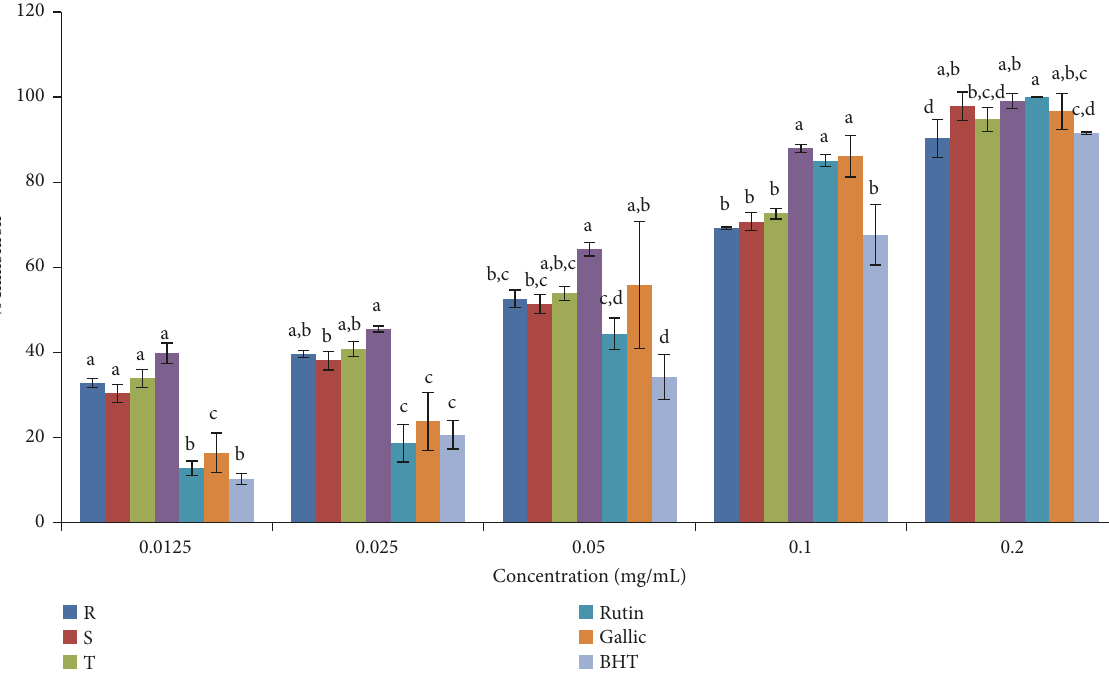
Figure 5: ABTS + radical scavenging activity of aqueous extract of the four varieties of Capsicum species. Values are mean ± SD of three replications. Set of bars having different letters are significantly different at (p < 0.05). R= C. annuum var. abbreviatum , S= C. annuum var. acuminatum , T= C. annuum var. grossum , and W= C. frutescens var . baccatum .